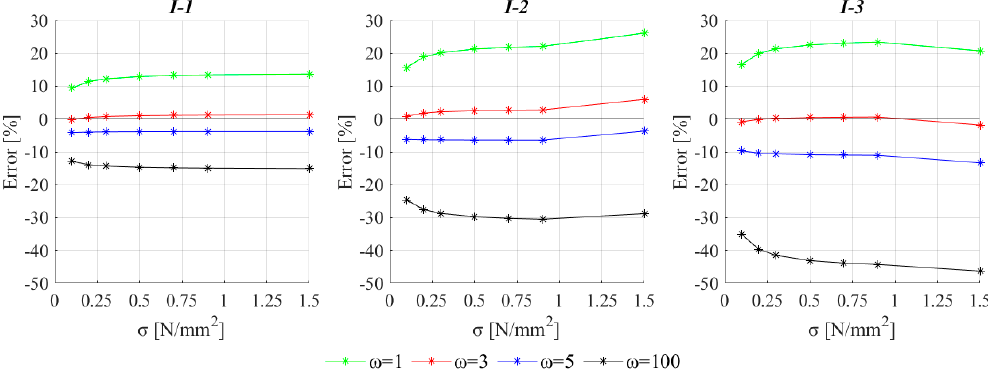
Figure 13. Percentage error on the estimate of the axial load just after the application of vertical loads ( d top = 0) for the examined I-shaped 3D assembly, as a function of average vertical stress.